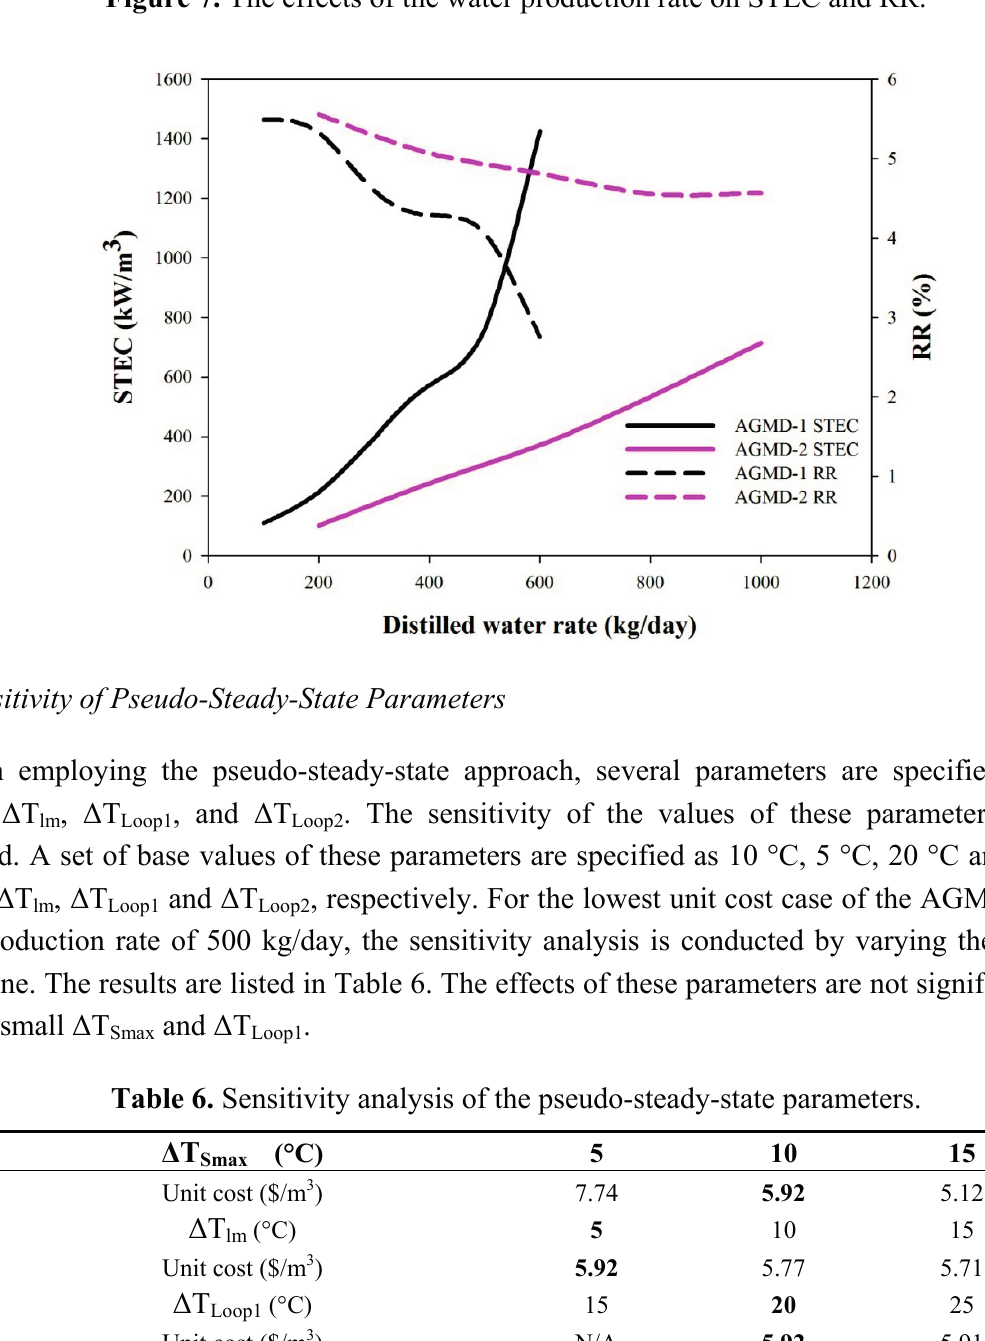
Figure 7. The effects of the water production rate on STEC and RR.